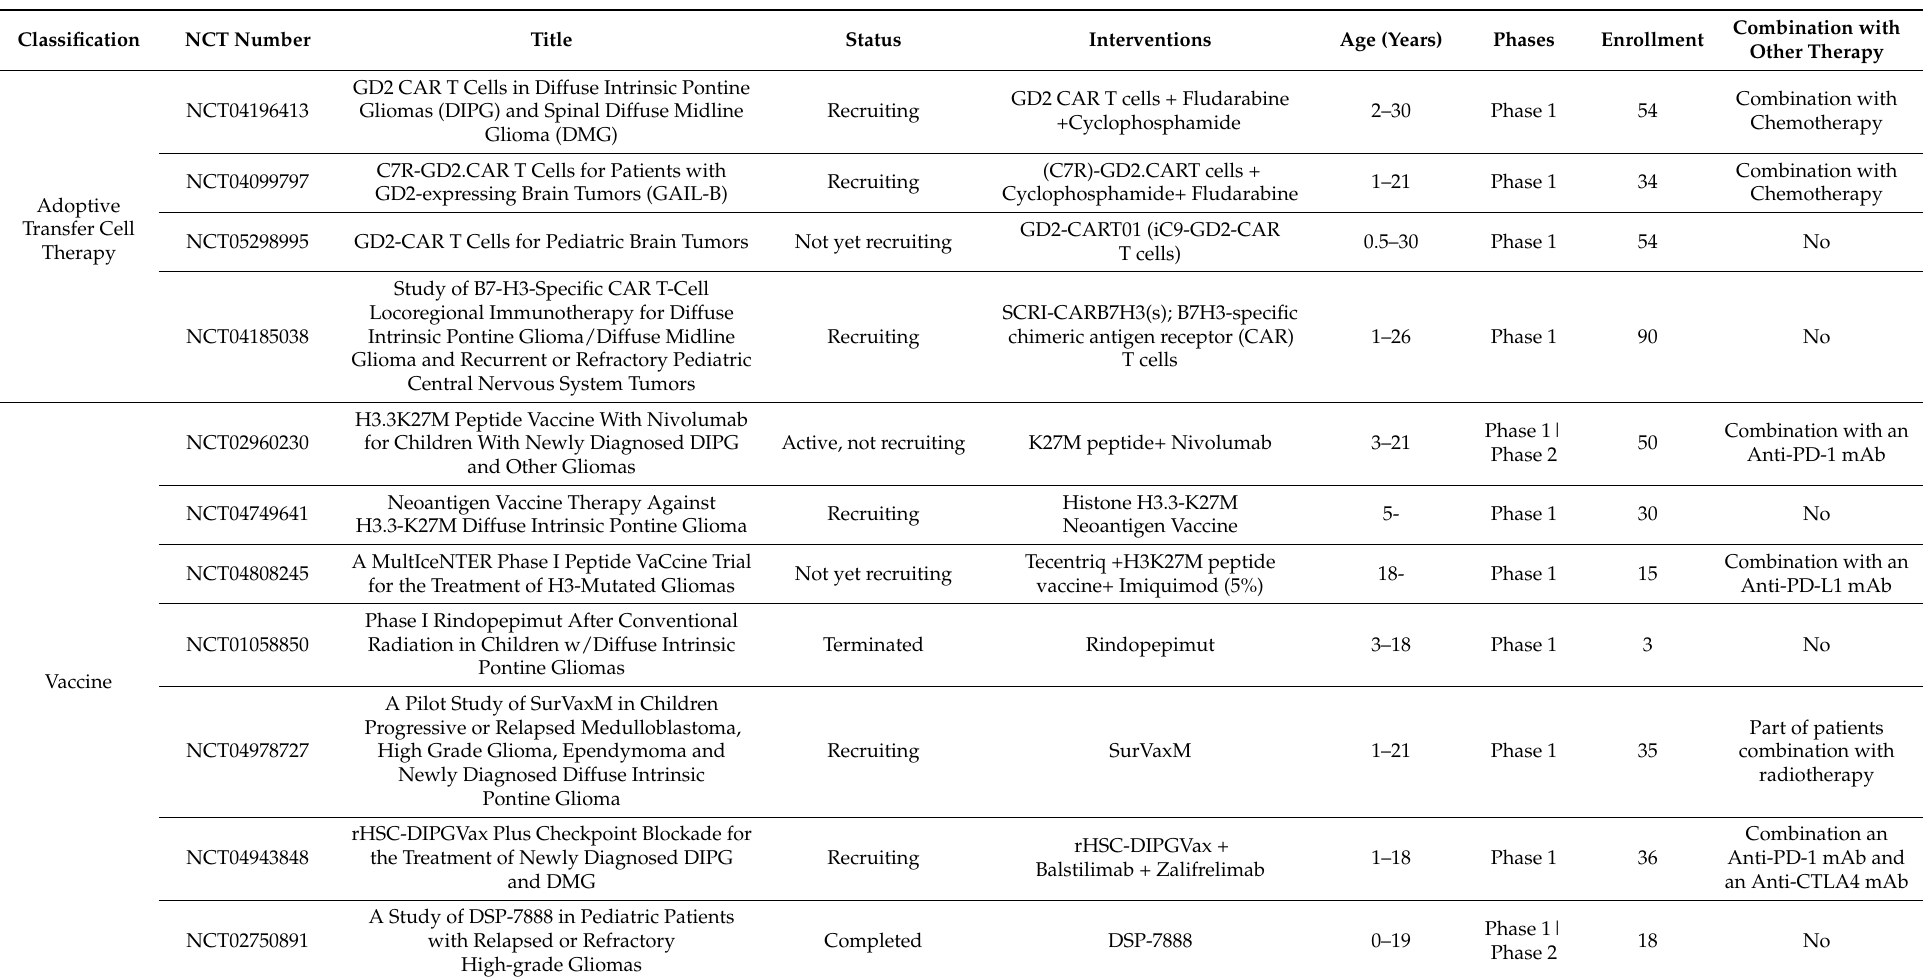
Table 1. The clinical trials of immunotherapies for